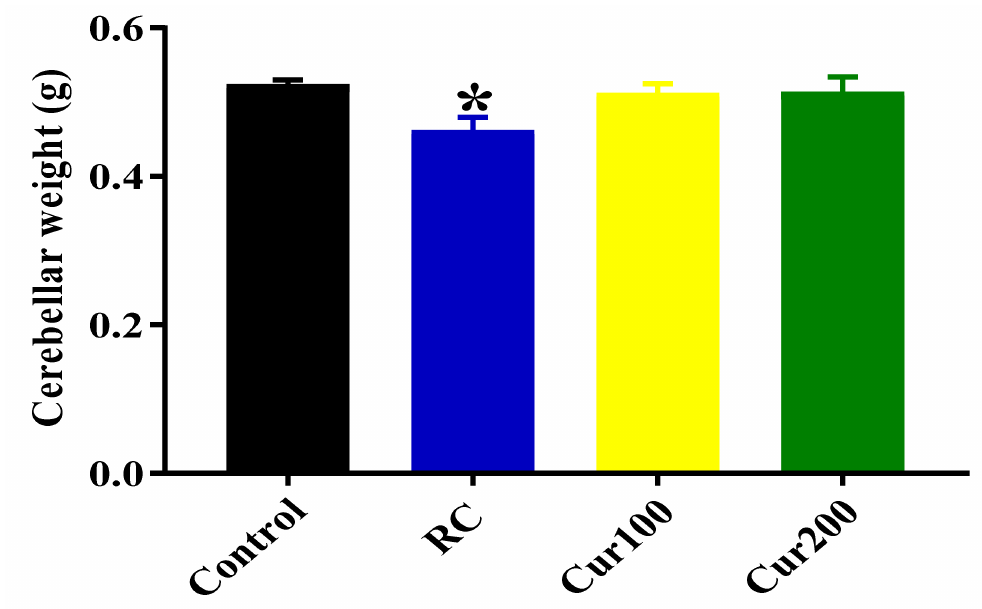
Figure 17. E ff ect of curcumin administration on cerebellar weights of Pb-induced rats. Data are represented as mean ± SEM ( n = 6); * p < 0.05 vs.